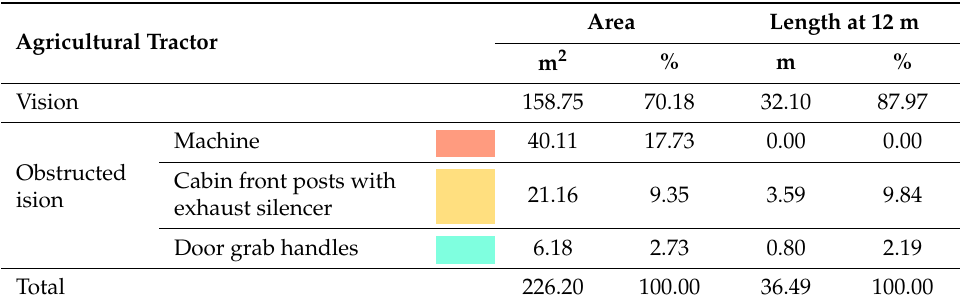
Table 3. Characteristics of the semi-circular vision to the front of agricultural tractor driver determined by the method of measuring the cast of shade by two light point sources in units of area and length.